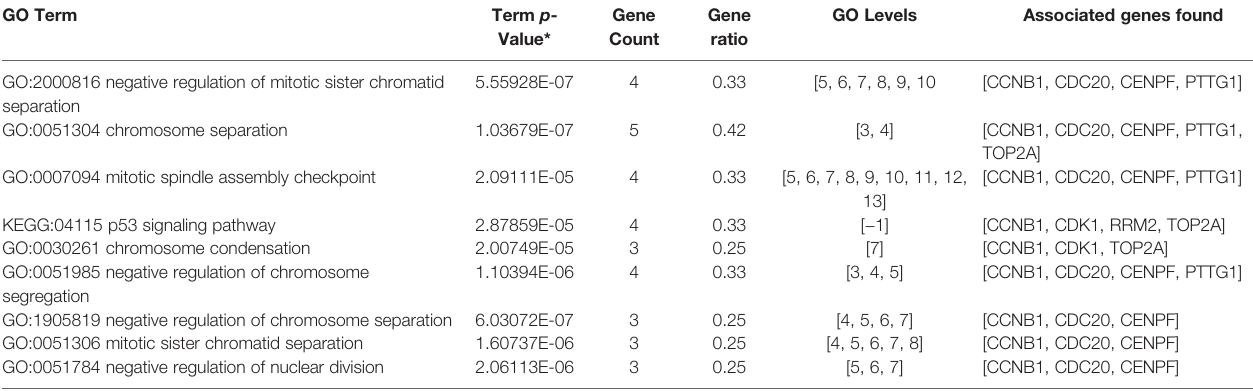
TABLE 2 | Enrichment analysis of the 12 selected genes using ClueGO